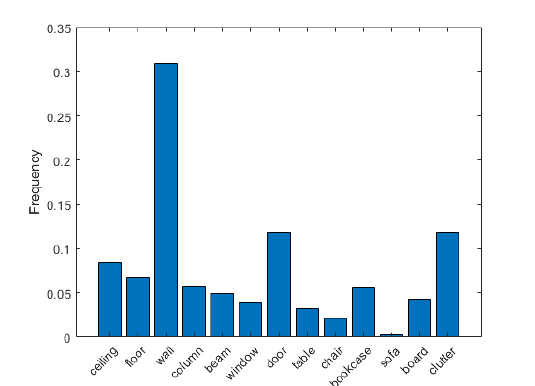
Figure 2. Class frequency in the training data.